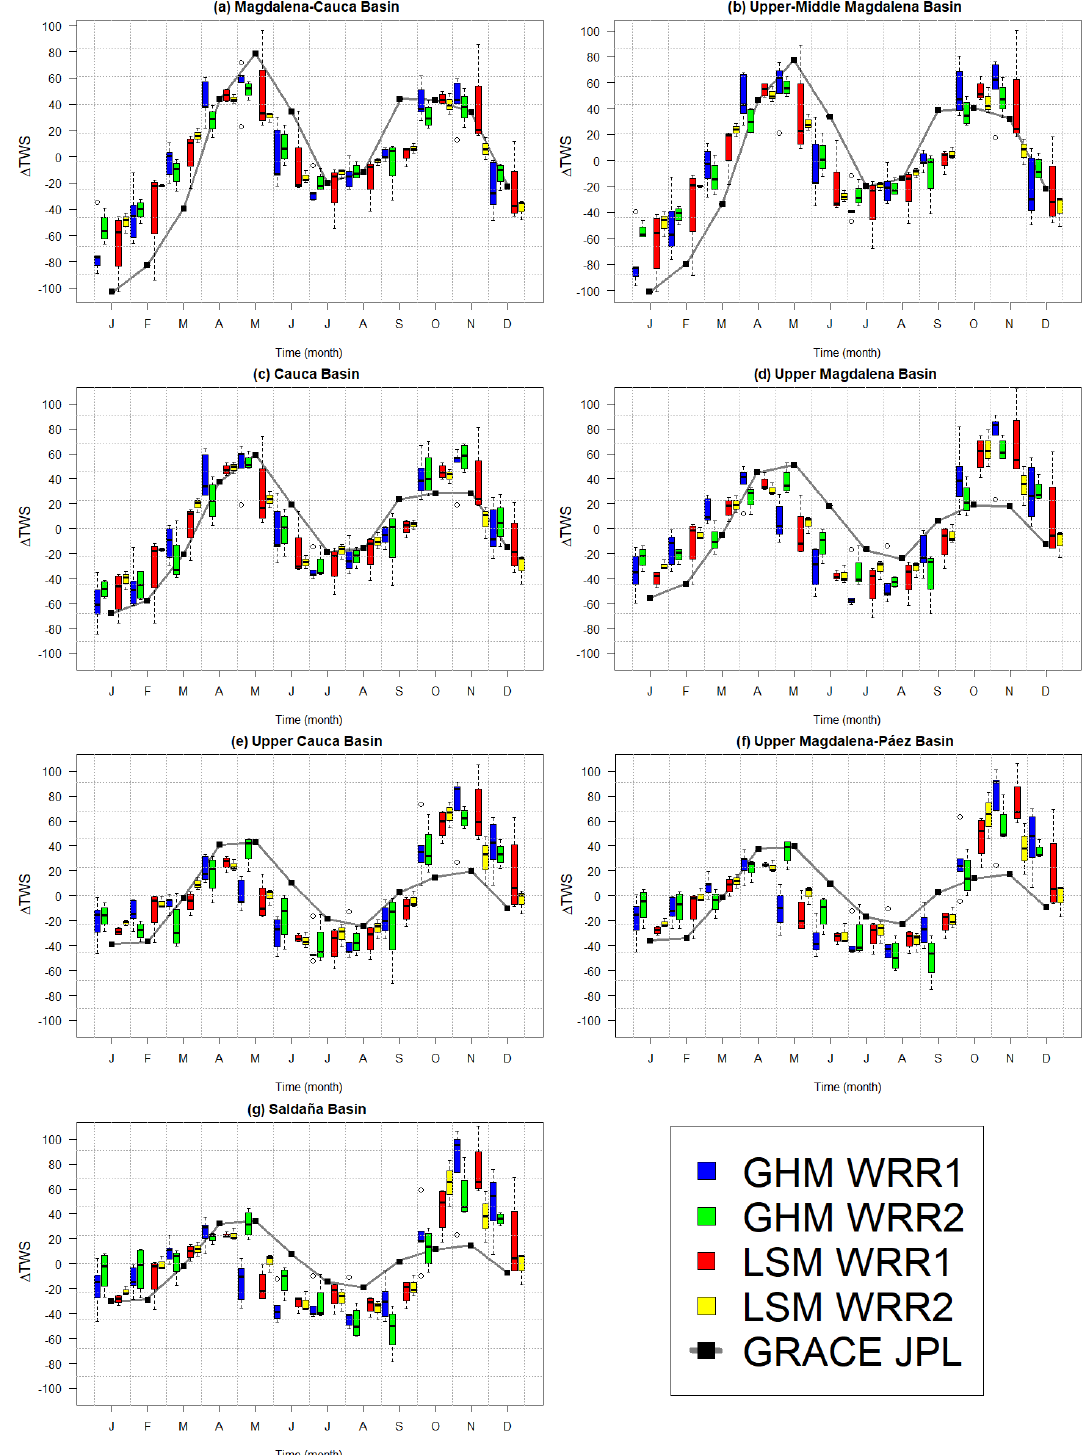
Figure 6. Comparative boxplots between the climatology of GHMs and LSMs, and GRACE JPL for each sub-basin.